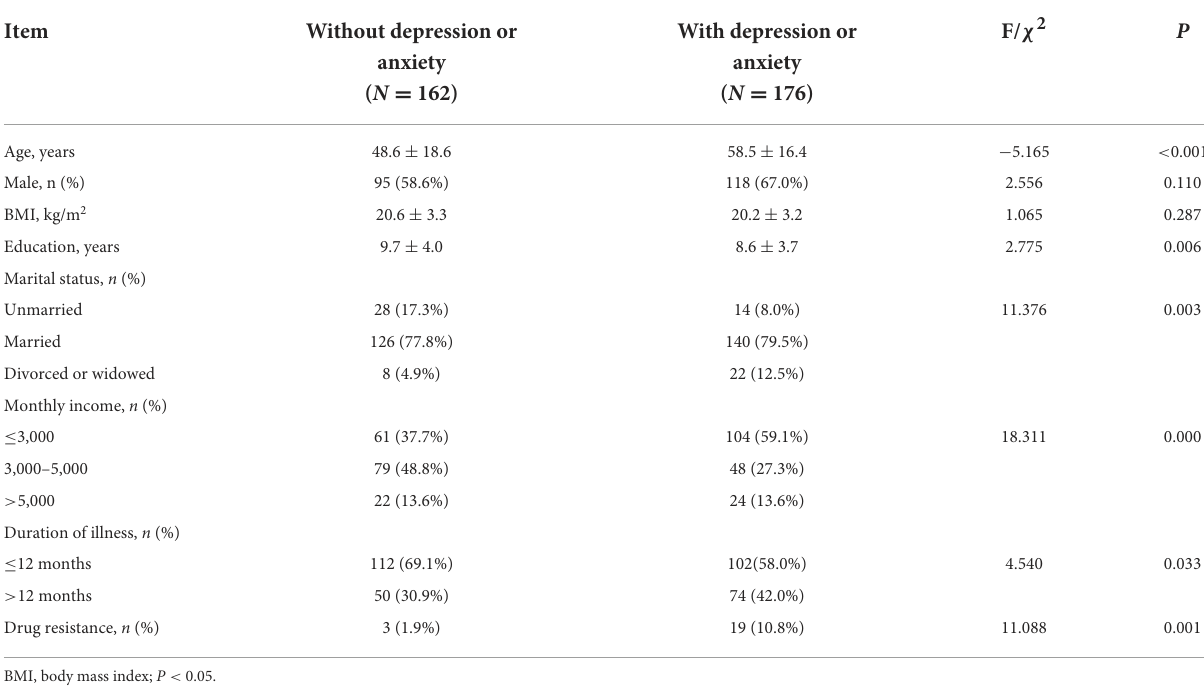
TABLE 1 Demographic characteristics in patients with tuberculosis.